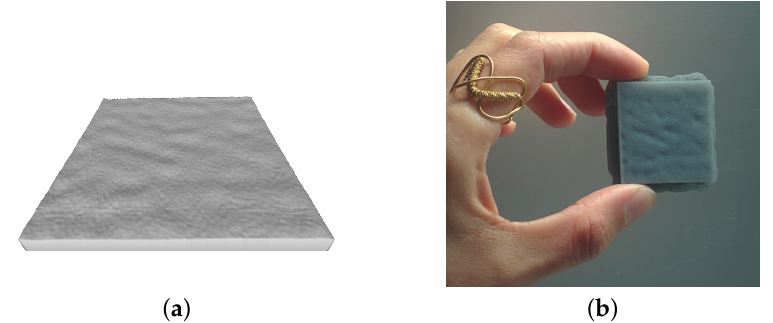
Figure 4. ( a ) Mesh of the enhanced surface T0 obtained from direct tessellation of the point cloud. This image represents the 3D printable STL file of the increased surface generated from the data. ( b ) 3D printed usable replica.